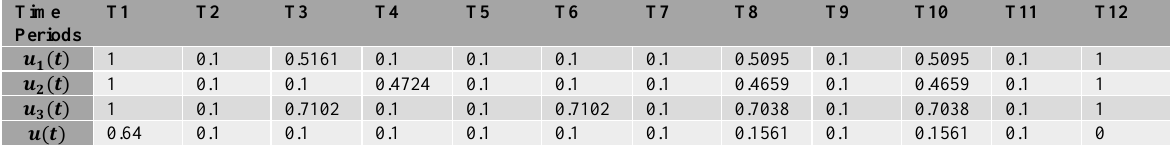
Table 2. Optimal value of segment specific and single channel advertising effort rate.